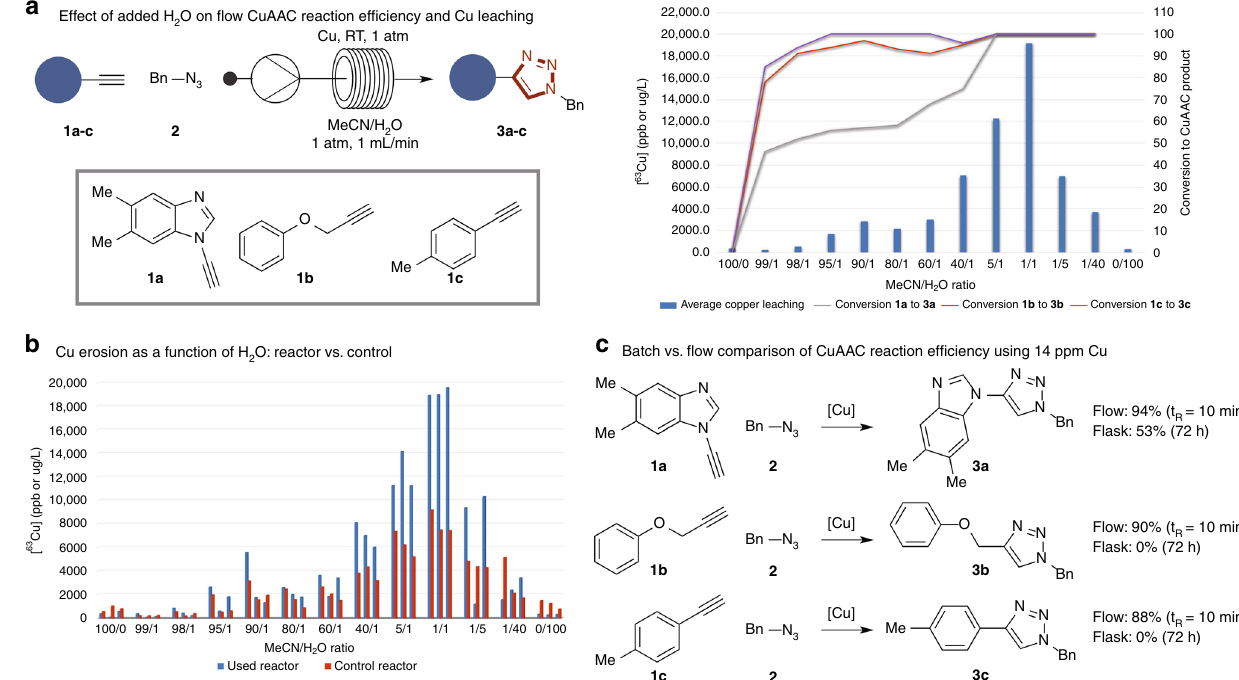
Fig. 2 Development of a fl ow CuAAC process based on H 2 O Cu erosion. a The effect of H 2 O on the CuAAC reaction ef fi ciency using three representative alkynes; b Correlation of [Cu] vs. solvent composition ((H 2 O]); c Demonstration of the fl ow effect — 14 ppm Cu CuAAC reactions in fl ow and in fl